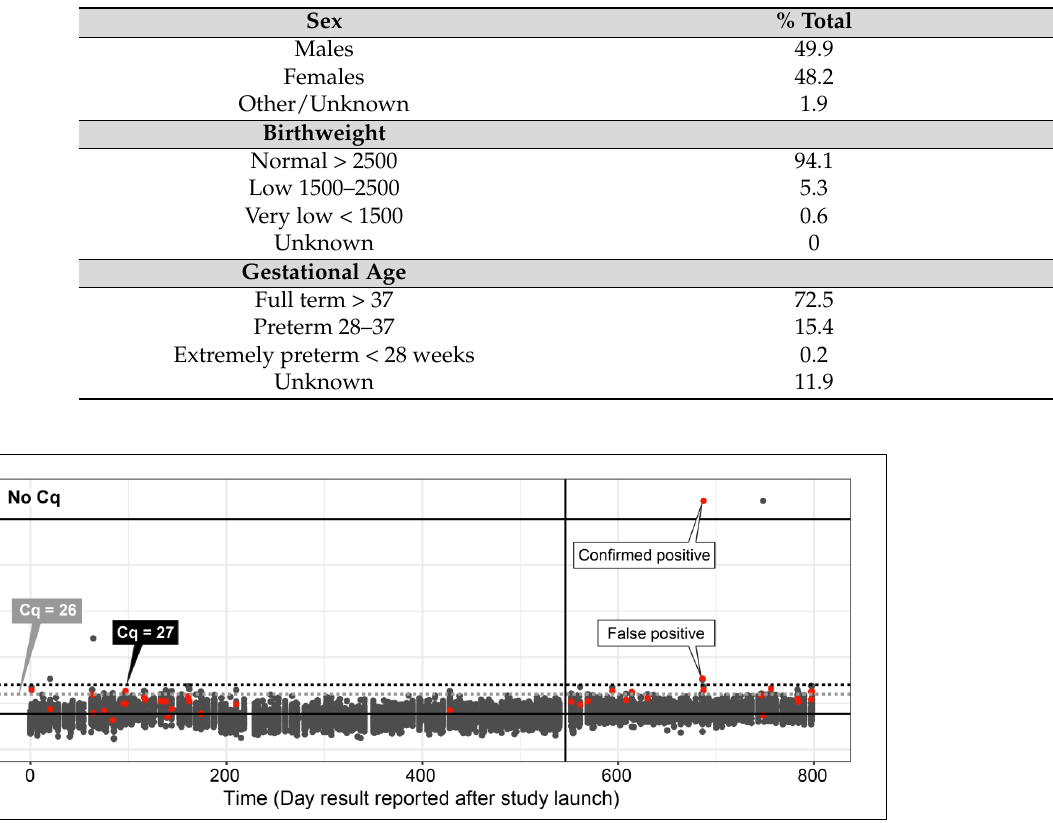
Figure 2. qPCR Cq values for newborn specimens screened for SMA by the EC study between October 2018 and December 2020. Initial testing (gray dots) was performed with a single 1.5 mm DBS punch. Specimens above initial cut-off Cq ≥ 26 (gray dotted line) were retested in duplicate (red dots). Specimens with repeat mean SMN1 Cq ≥ 27 and RPP30 Cq < 26 were reported as screen-positive at follow-up. Gray dots above the cut-off indicate initial results that resolved on retest. Reporting of negative results was paused for 7 days during the lab move, shown by a gap in the data and a vertical line at ~550 days after study launch. Solid horizontal black lines indicate overall mean from all screens Cq = 23.84 and maximum number of qPCR cycles used Cq = 45. Results shown by dots above Cq = 45 had a “No Cq” value.